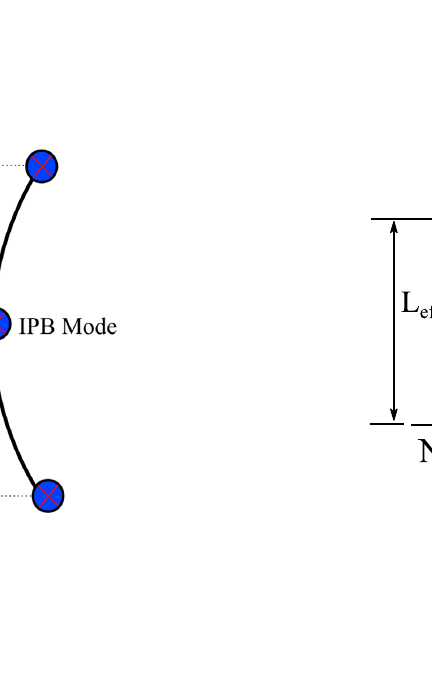
Figure 9. Illustration of ( a ) the modes of buckling and ( b ) the gusset plate stability model. It is very difficult to developed analytical formula to evaluate the plan of buckling due to the uncertainties involved in the IPB braced frame system. Patra and Sahoo [39–41] proposed a simplified analytical equation incorporating the uncertainties empirically using the multivariate regression analysis, as shown in Equation (1). <1 → IPB mode